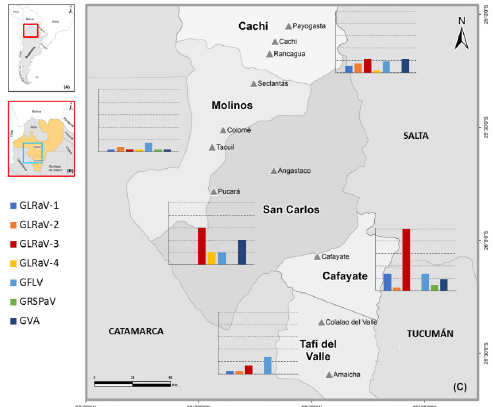
Figure 1. Map showing the sampling localities for the grapevine virus survey in northwestern Argentina. ( A ) Map highlighting the location of northwestern Argentina. ( B ) Map of northwestern Argentina showing sampled provinces. ( C ) Sampled locations ( ▲ ) and geographic distribution of viruses detected among localities (bar charts). The viruses shared between sites are represented by the same color. Percentage of positive samples is indicated on the y axis. Dotted lines represent 20% increments.